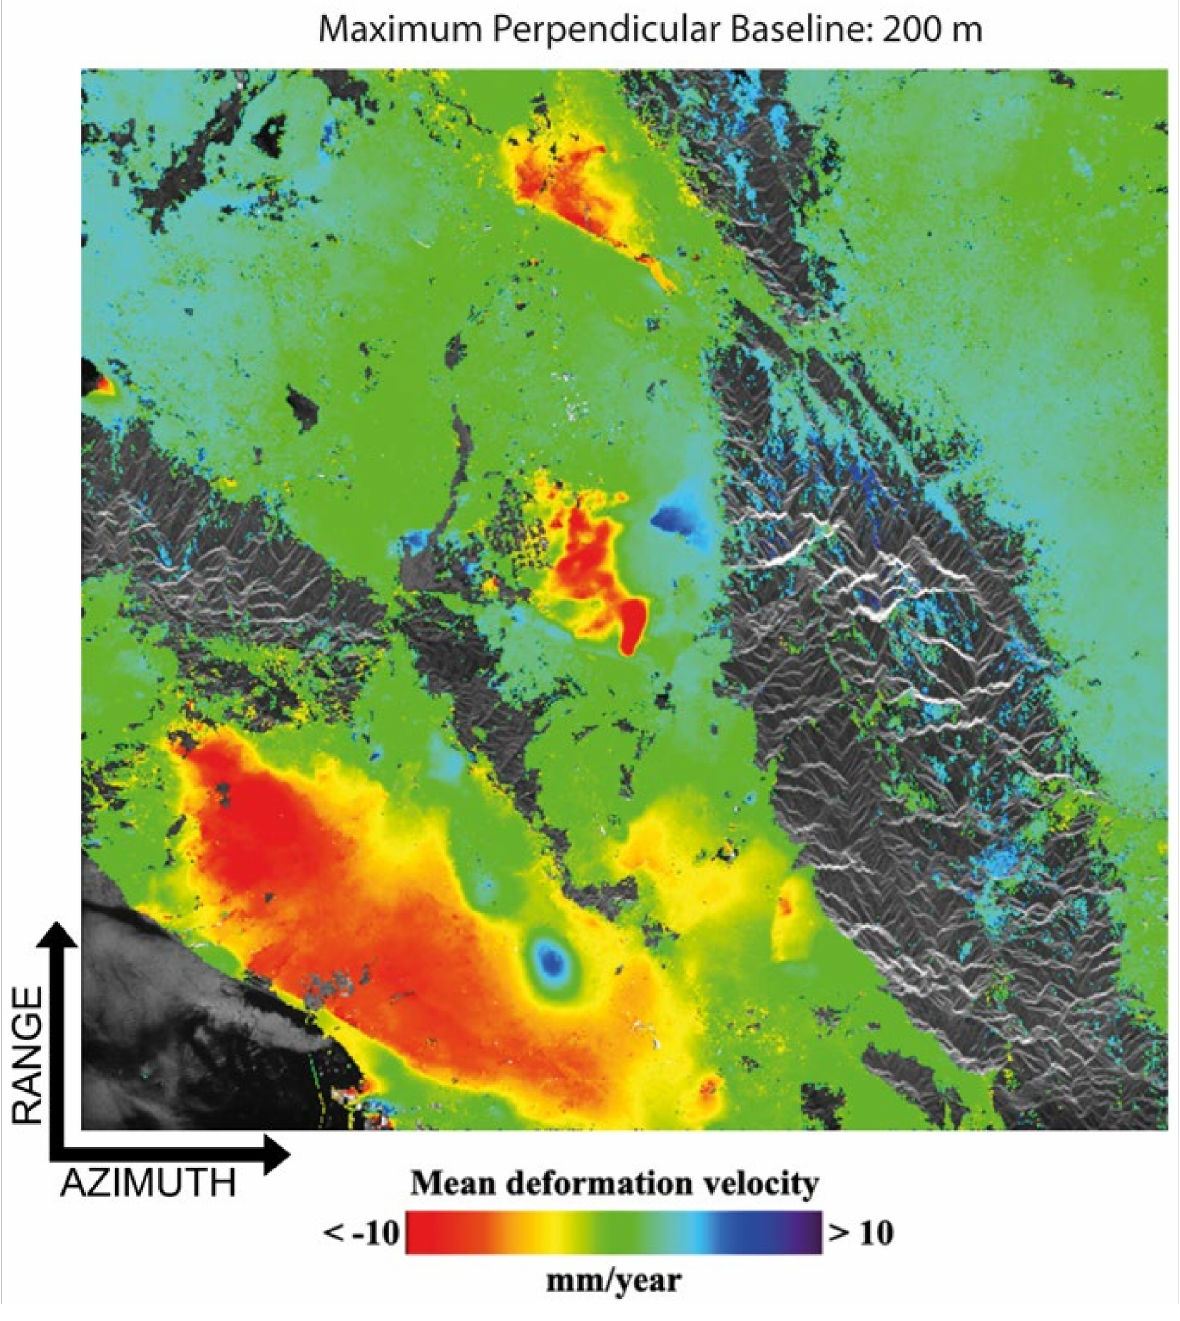
Figure 10. 2003–2010 Mean deformation velocity map of South California obtained using the SBAS method to the group of SB interferograms identified in Figure 9e and corresponding to a maximum value of the InSAR perpendicular baselines equal to 200 m. The map is in radar coordinates, and the ground deformation is superimposed on an amplitude SAR image of the area. Shown deformation values are saturated between +/ − 10